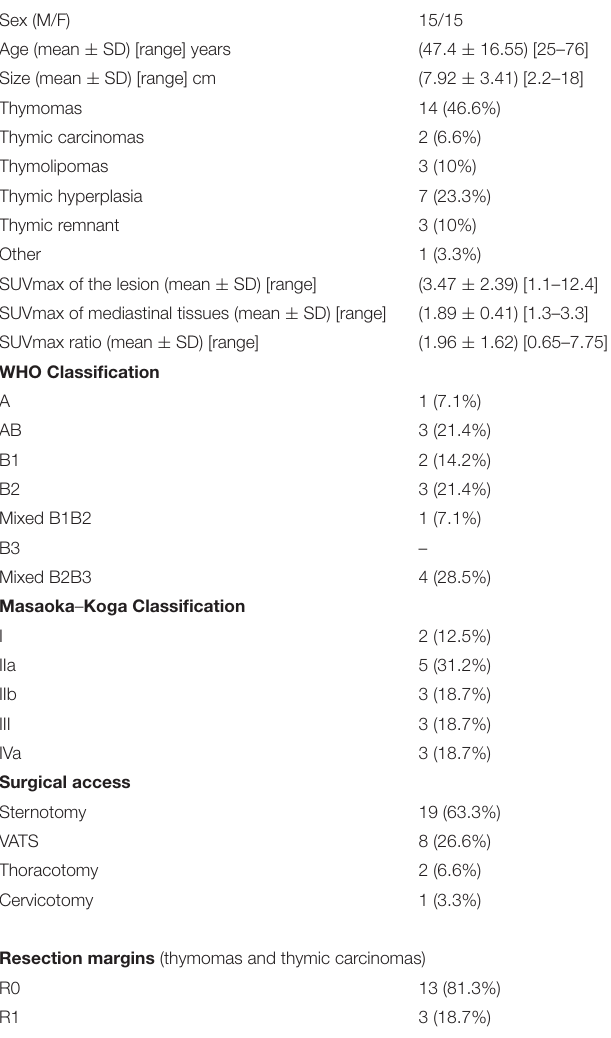
TABLE 1 | Demographics and other patients’ characteristics. TABLE 2 | Comparison of the two groups of patients according to the SUVmax